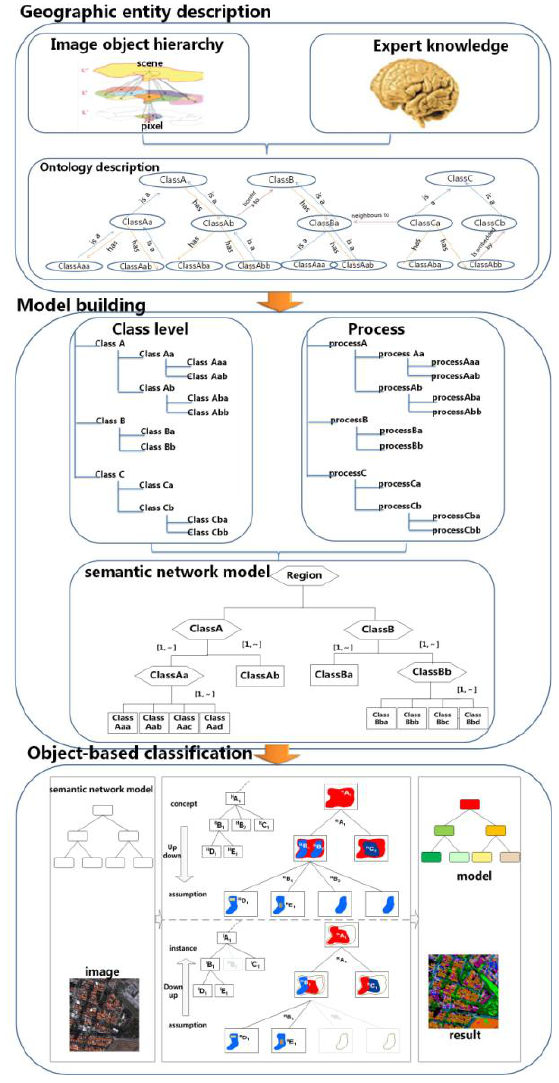
Figure 1. Geographic ontology driven GEOBIA